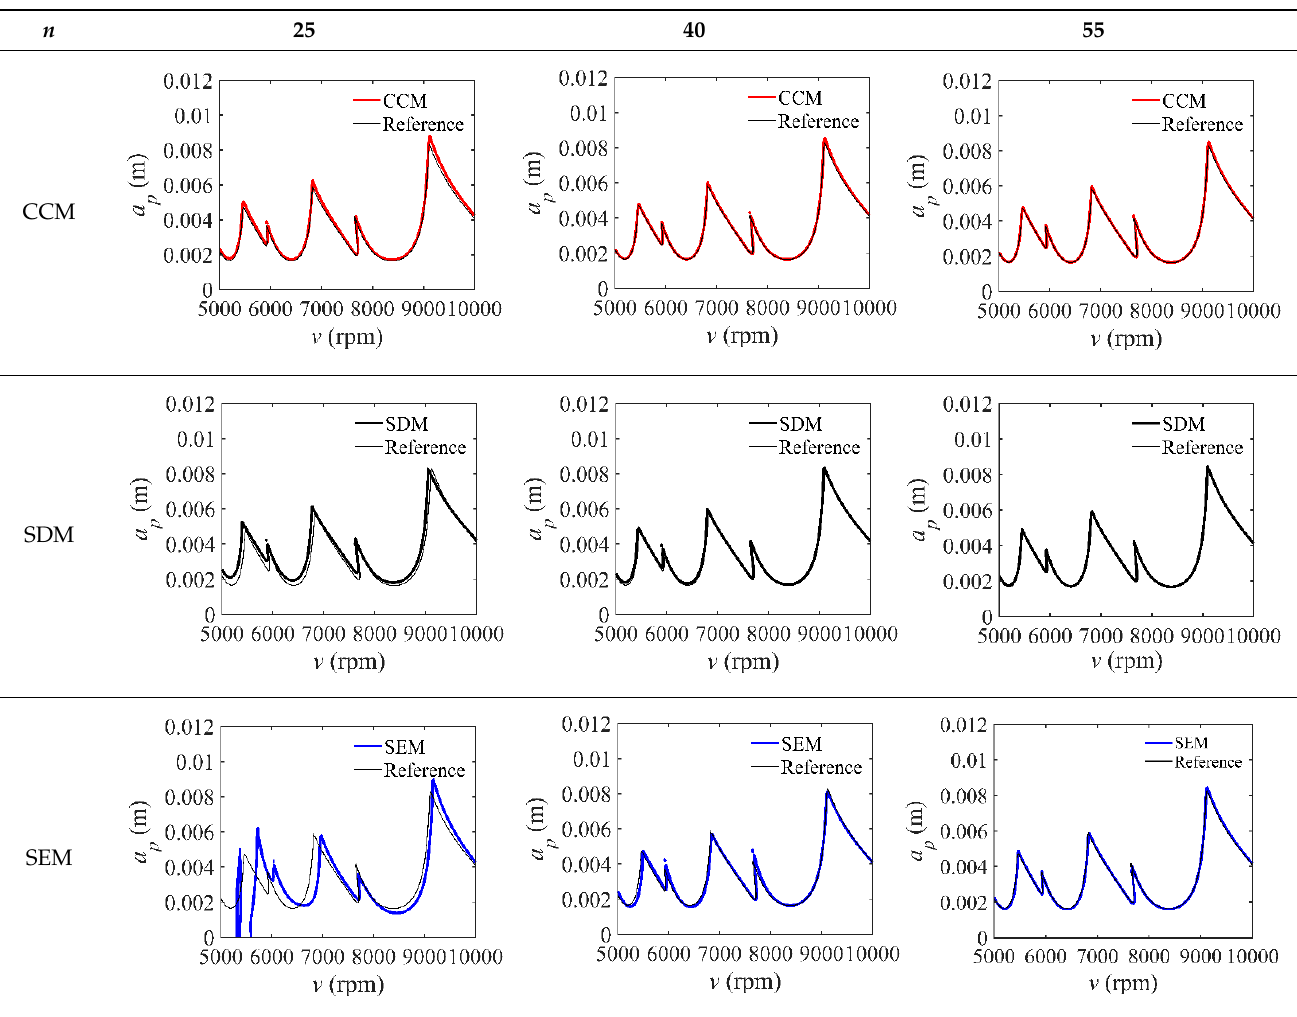
Table 2. Stability lobe diagrams of the CCM, SDM, and SEM when a / D = 0.05.